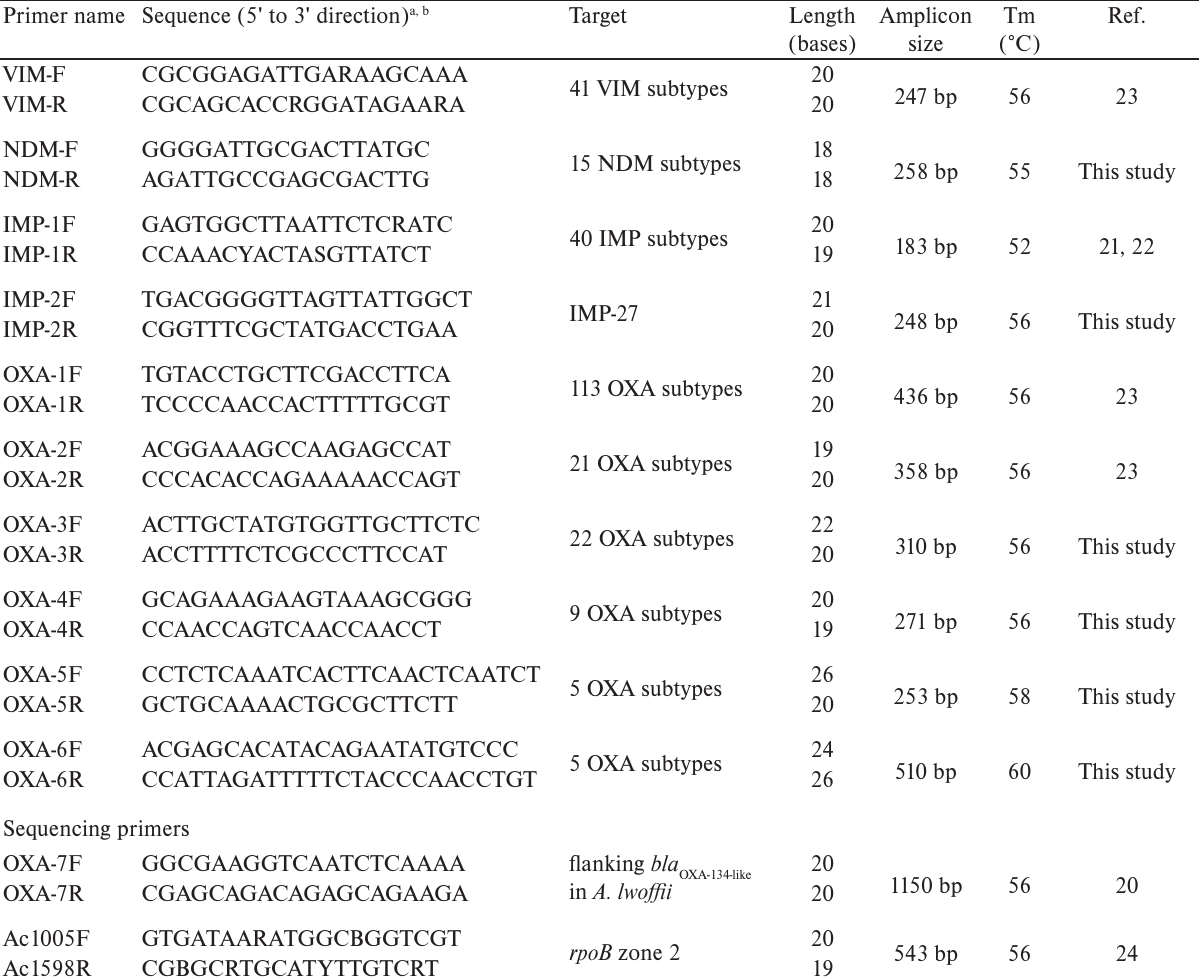
Table 2. Sequences of primers used for PCR for detection of genes encoding β -lactamases and carbapenemases, and rpoB gene